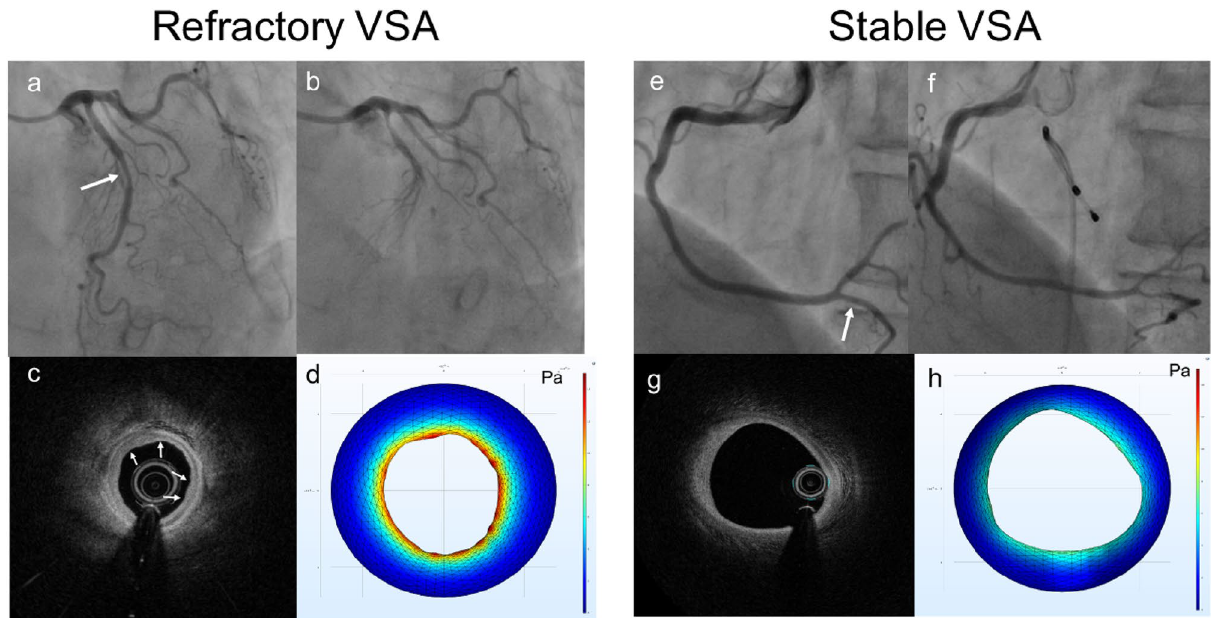
Figure 2. Coronary angiograms, optical coherence tomography (OCT) images, and shear stress map. ( a , b ) Angiograms of baseline and provocation test in the refractory vasospastic angina (VSA) group. Mild stenosis can be seen in the middle portion of the left descending coronary artery (white arrow). During the provocation test, total occlusion was observed at the mid-position of the left descending coronary artery. ( c ) OCT image at baseline in the refractory VSA group intimal bumps (white arrows) can be seen in the OCT image of the refractory VSA. The shear stress is higher in refractory VSA than in stable VSA. ( d ) Shear stress map. The shear stress is higher in refractory VSA than in stable VSA. ( e , f ) Angiograms of baseline and provocation tests in stable VSA. No stenosis can be seen in the angiogram at baseline (white arrow). During the provocation test, severe stenosis can be seen in the distal portion of the right coronary artery. ( g ) OCT image at baseline in stable VSA. No intimal bumps can be seen in the OCT image of the stable VSA. ( h ) Shear stress map. The shear stress has lower values in stable VSA than in refractory Figure 3 shows the maximum and minimum shear stress of the two groups. The maximum shear stress in the refractory VSA group was higher than that in the stable VSA group (refractory VSA group 14.5 [12.1–18.8] Pa vs stable VSA group 5.6 [3.0–10.5] Pa, p = 0.003). The minimum shear stress was also higher in the refrac- tory VSA group compared to that in the stable VSA group (refractory VSA group 7.0 [4.9–9.7] Pa vs stable VSA group 3.0 [1.6–3.8] Pa, p = 0.02). Figure 4 shows the relationship between the shoreline development index and shear stress. The shoreline development index positively correlates with shear stress (R 2 = 0.46, P = 0.004).